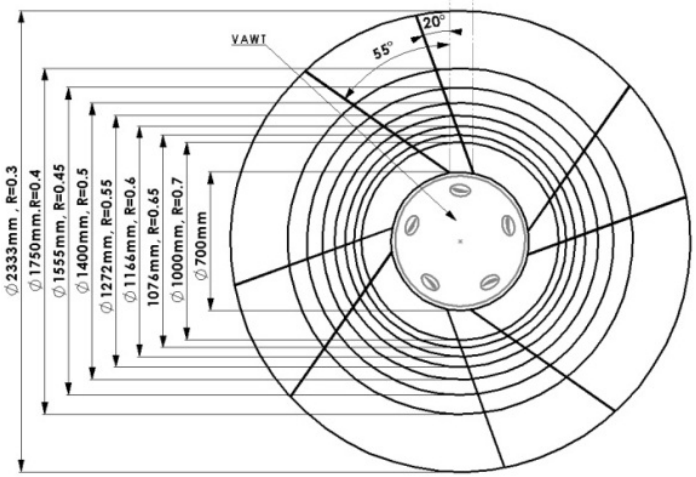
Figure 3. Shape ratio of the ODGV.